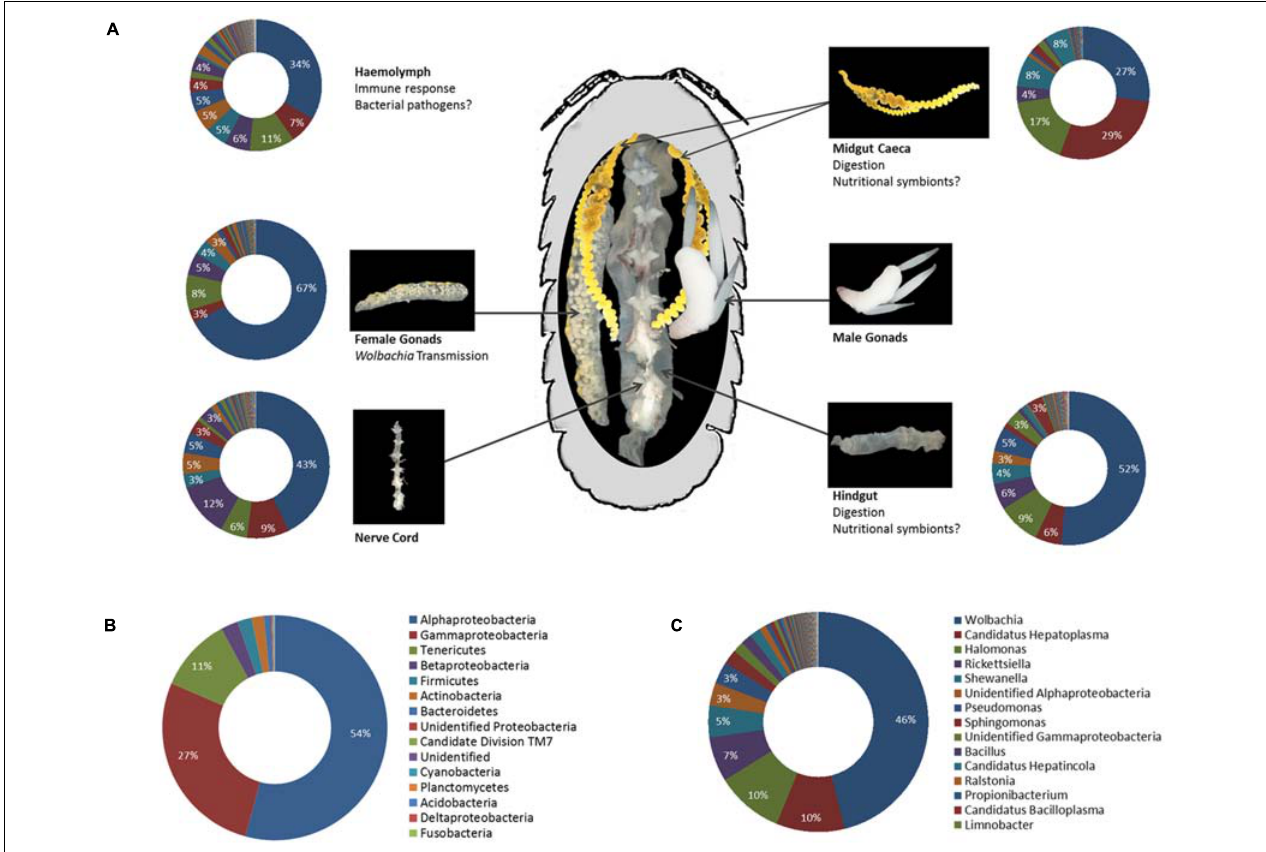
FIGURE 5 | (A) Representation of the microbiota in different tissues of A. vulgare (modified from Dittmer et al., 2016). Note that data from males and females are combined, therefore the chart illustrating the microbiota in the gonads represents both male and female gonads. The legend for all charts is the same as in (C) . (B,C) The microbiome of A. vulgare for all tissues combined, at the phylum (B) and genus (C) level. Proteobacteria are represented at class level. Legends show the 15 most abundant phyla/classes and genera, respectively.